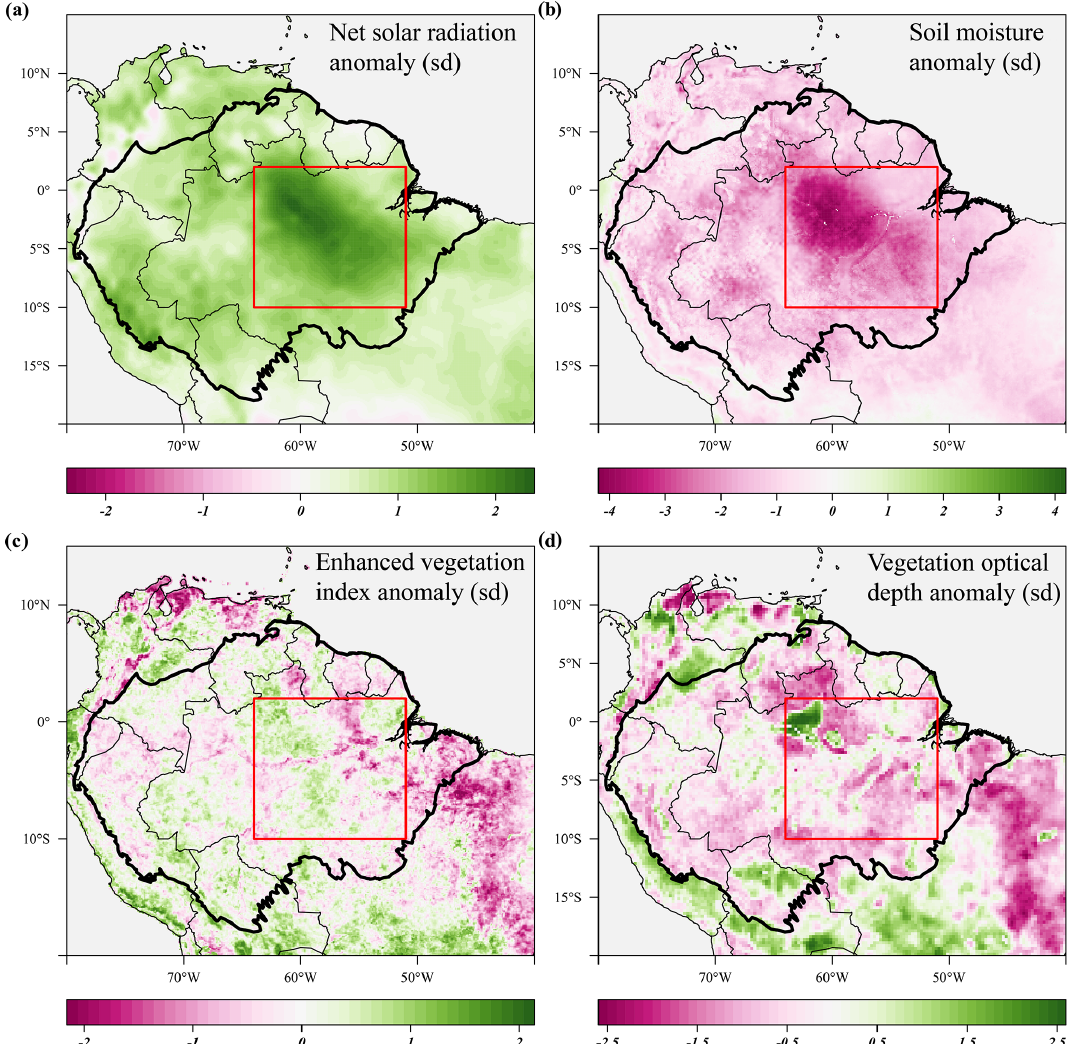
Figure 4. Standardized anomalies in net solar radiation (a) , soil moisture (b) , enhanced vegetation index (c) and X-band vegetation optical depth (d) during the 2015 drought (August 2015–January 2016) compared to their long-term monthly averages. Soil moisture anomalies are calculated from the ERA-5 volumetric soil moisture in the first soil layer (L1). Country borders and the extent of the Amazon basin are marked by thin and thick black lines, respectively. The red rectangle delineates the drought area for which further results are